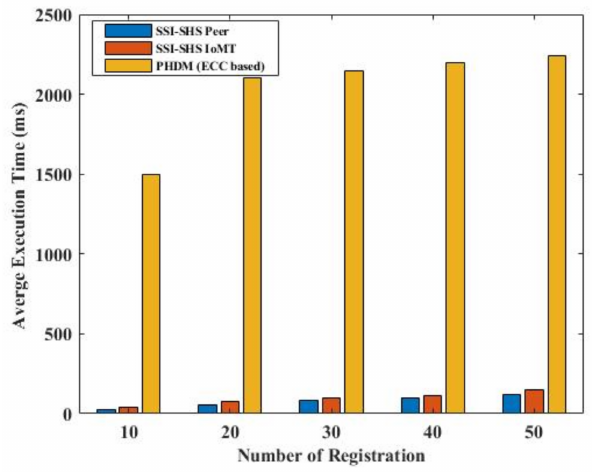
Figure 10. Performance